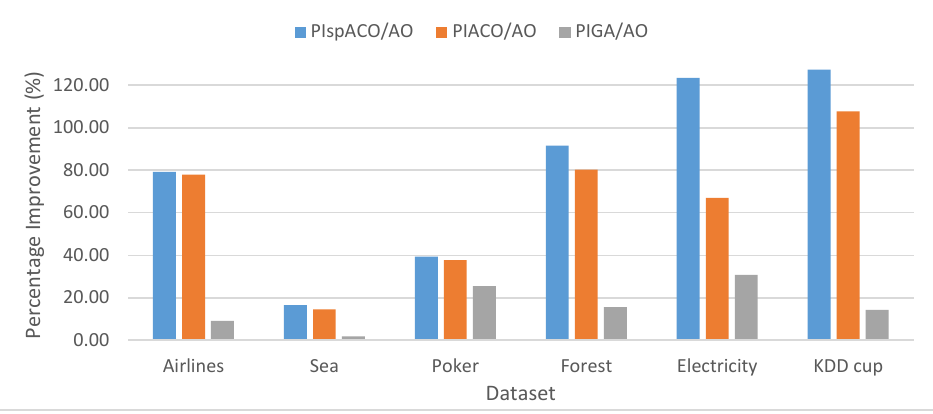
Table 4. Evaluation of PCAES index.